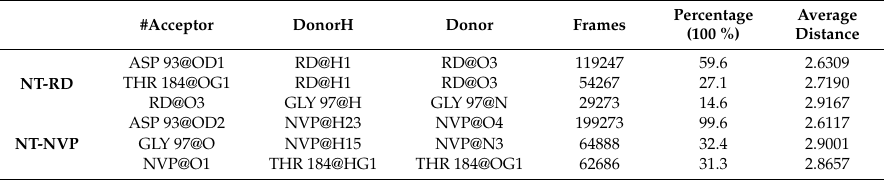
Table 4. Percentage (%) Occupancy and average distance (Å) between the ligand and prominent active site residues calculated over simulation